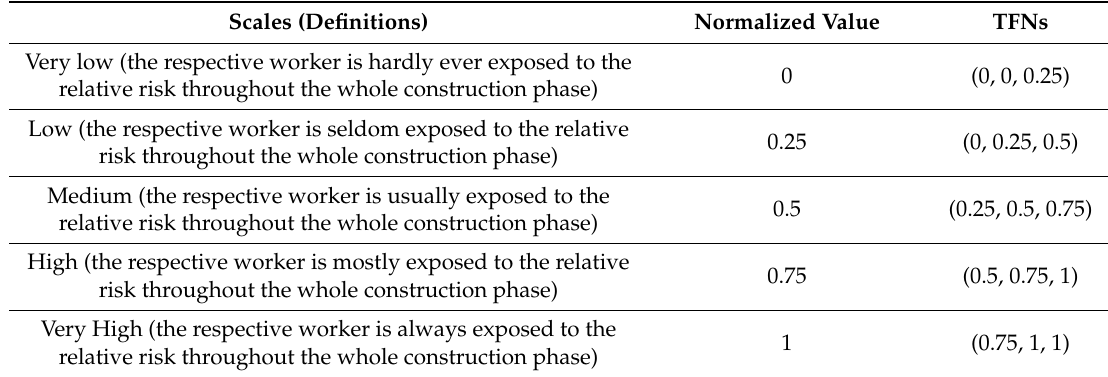
Table 4. Linguistic variables for Exposure.